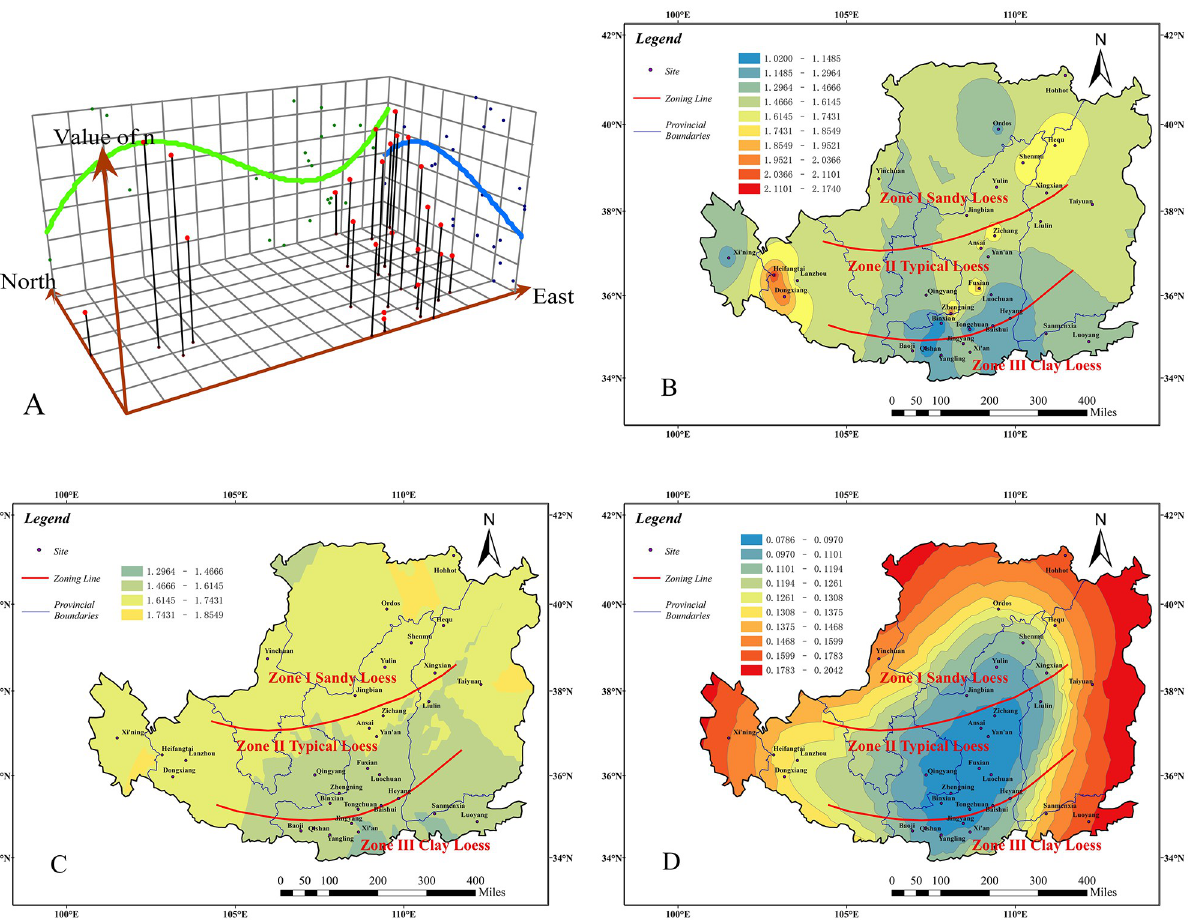
Fig 4. Analysis result of parameter n . Trend analysis graph(A). measured value contour graph(B). prediction value contour graph(C). prediction standard error value graph(D) (Only the boundary of the Loess Plateau comes from Huang [32], illustrative purposes only).